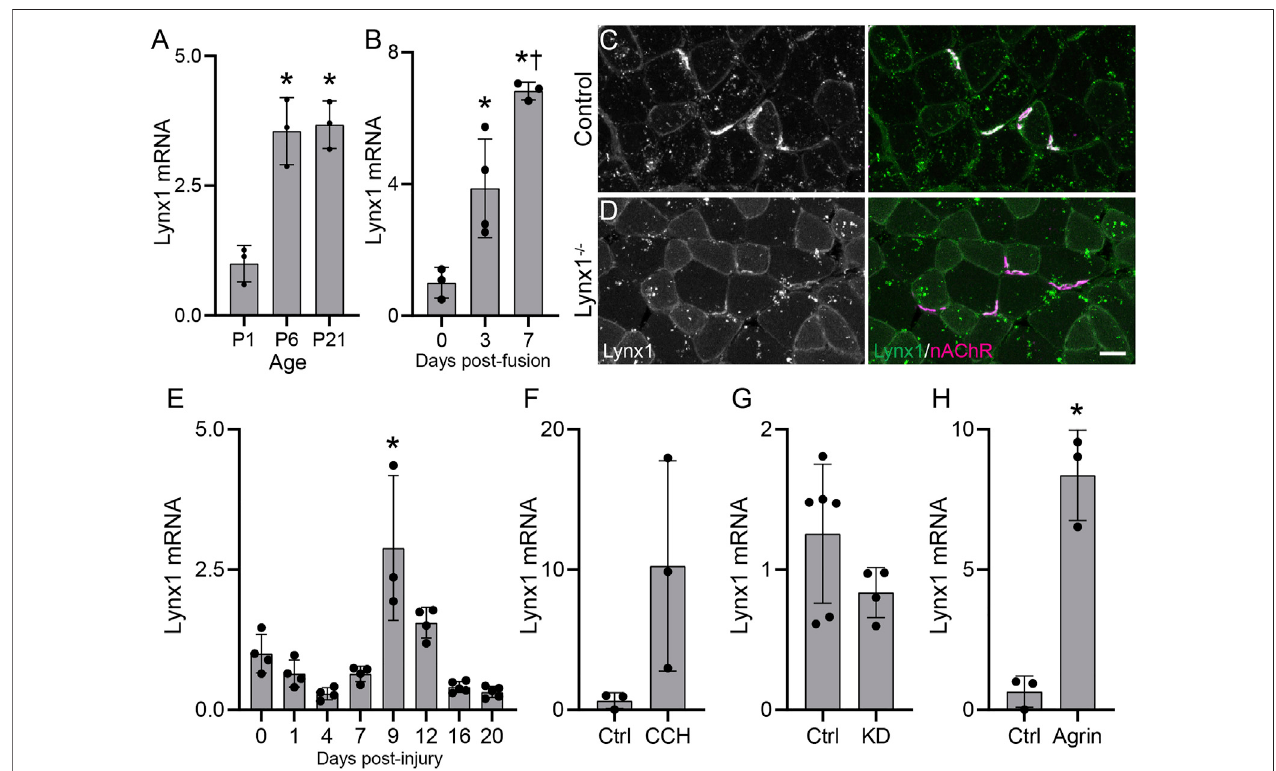
FIGURE 1 | Lynx1 levels track structural and functional changes at neuromuscular junctions (NMJs). (A,B) qPCR analysis of Lynx1 mRNA levels in (A) developing tibialis anterior (TA) and extensor digitorum longus (EDL) muscles and in (B) C2C12 myotubes at 3 and 7 days post-fusion compared to unfused myoblasts; * p < 0.05 versus P1 or control. † p < 0.05 versus 3 days post-fusion, one-way ANOVA with Bonferroni post hoc . (C,D) Representative images of Lynx1 (green) and fl uorescently conjugated α -bungarotoxin (fBTX)-labeled nicotinic acetylcholine receptors (magenta) in control and Lynx1 − / − TA muscle cross-sections. (E,F) qPCR analysis of Lynx1 mRNA levels in (E) the TA muscle following fi bular nerve crush injury, (F) C2C12 myotubes following 24-h carbachol (CCH) treatment, (G) the TA muscle of vesicular acetylcholine transporter (VAChT) knockdown (KD) mice, and (H) C2C12 myotubes following 24-h z-agrin treatment. * p < 0.05 versus P1 or control, one-way ANOVA with Bonferroni post hoc . All values are mean ± SD. Scale bar = 25